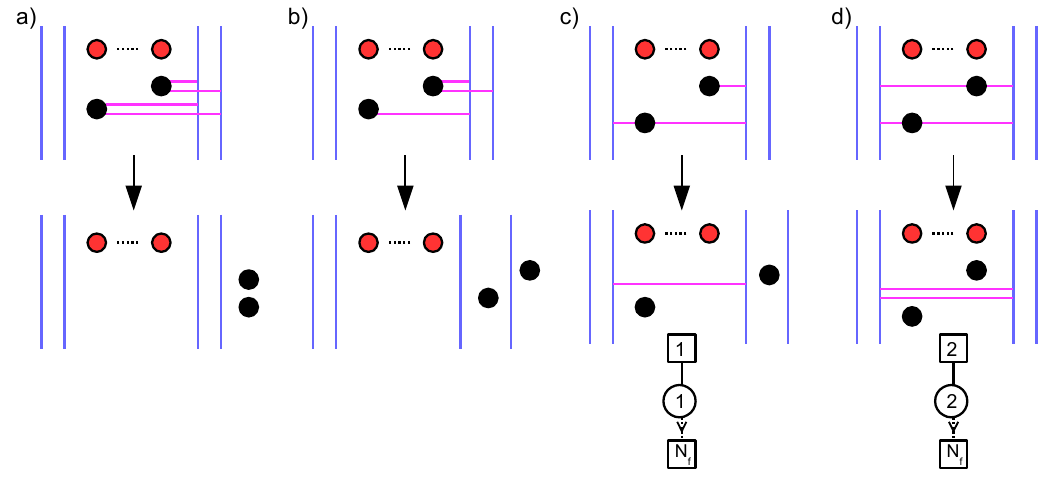
Figure 5 . Brane patterns for two-point correlators in the U(2) SQCD theory and associated SMM. a) h V 2 i , b) h V V i , c) h V V i , d) h V V i (1 ; 0) (1 ; 1) (1 ; 1) (0 ; (cid:0) 1) (1 ; 1) ( (cid:0) 1 ; (cid:0) 1) (1 ; 1)